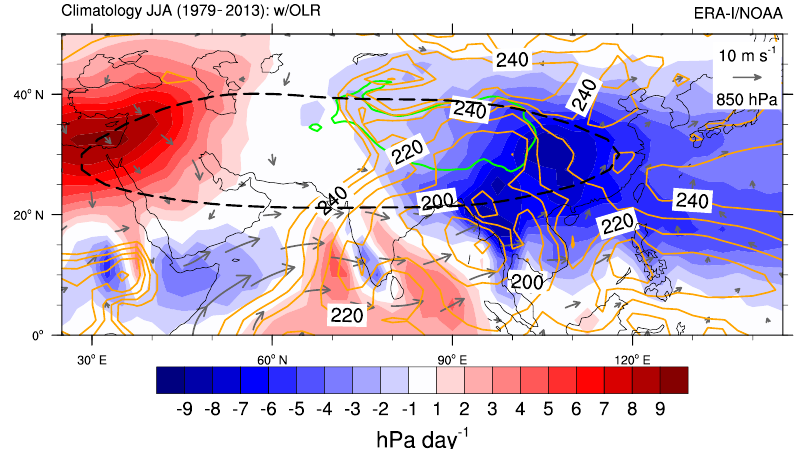
Figure 10. Mean vertical velocity (hPaday − 1 ) at 100hPa during JJA (1979–2013) as diagnosed from ERA-I. Upward (downward) winds are indicated by blue (red) colours. Orange contours show mean OLR (Wm − 2 ) starting from 250 to 180Wm − 2 in steps of 10Wm − 2 during the same period. Black dashed contour indicates the climatological mean position of the SAH (16.72km contour of geopotential height at 100hPa). Arrows show the mean JJA (1979–2013) 850hPa horizontal winds from ERA-I. Green contour indicates the 3km contour of the Tibetan